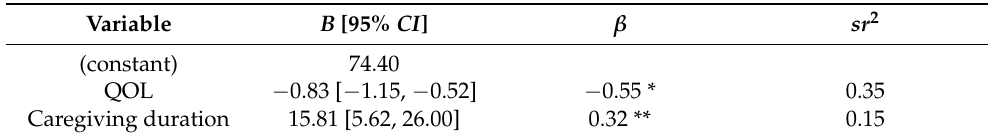
Table 3. Unstandardized ( B ), standardized ( β ) regression coefficients, and squared semi-partial correlations ( sr 2 ) for each predictor in the regression